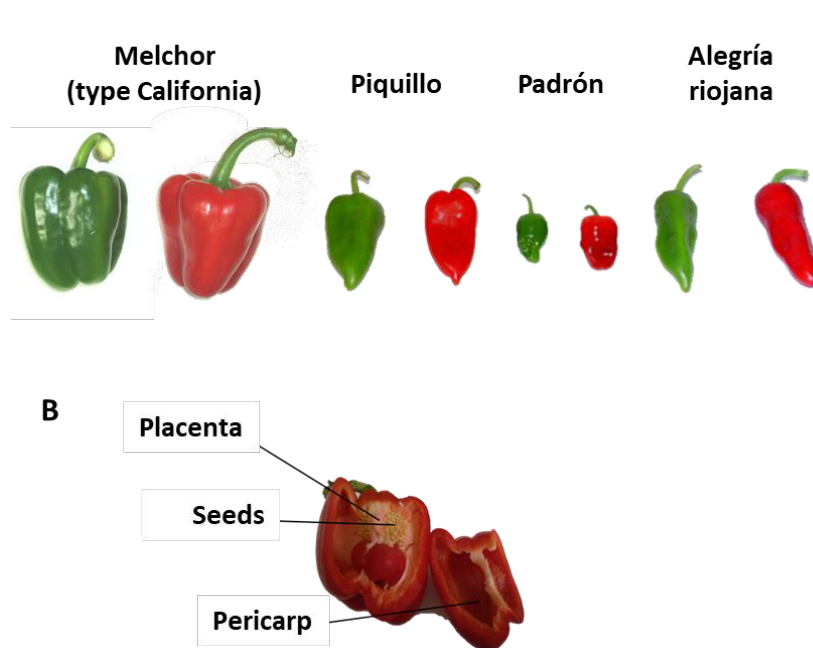
Figure 1. Representative pictures of plant materials used in this work. ( A ) Fruits from the four varieties at two ripening stages: green and ripe red. Melchor is a variety of California-type sweet pepper fruit. Piquillo Padrón and Alegría riojana contain different levels of capsaicin with the sequence Piquillo <<< Padrón < Alegría riojana. ( B ) Different parts of the pepper fruit.